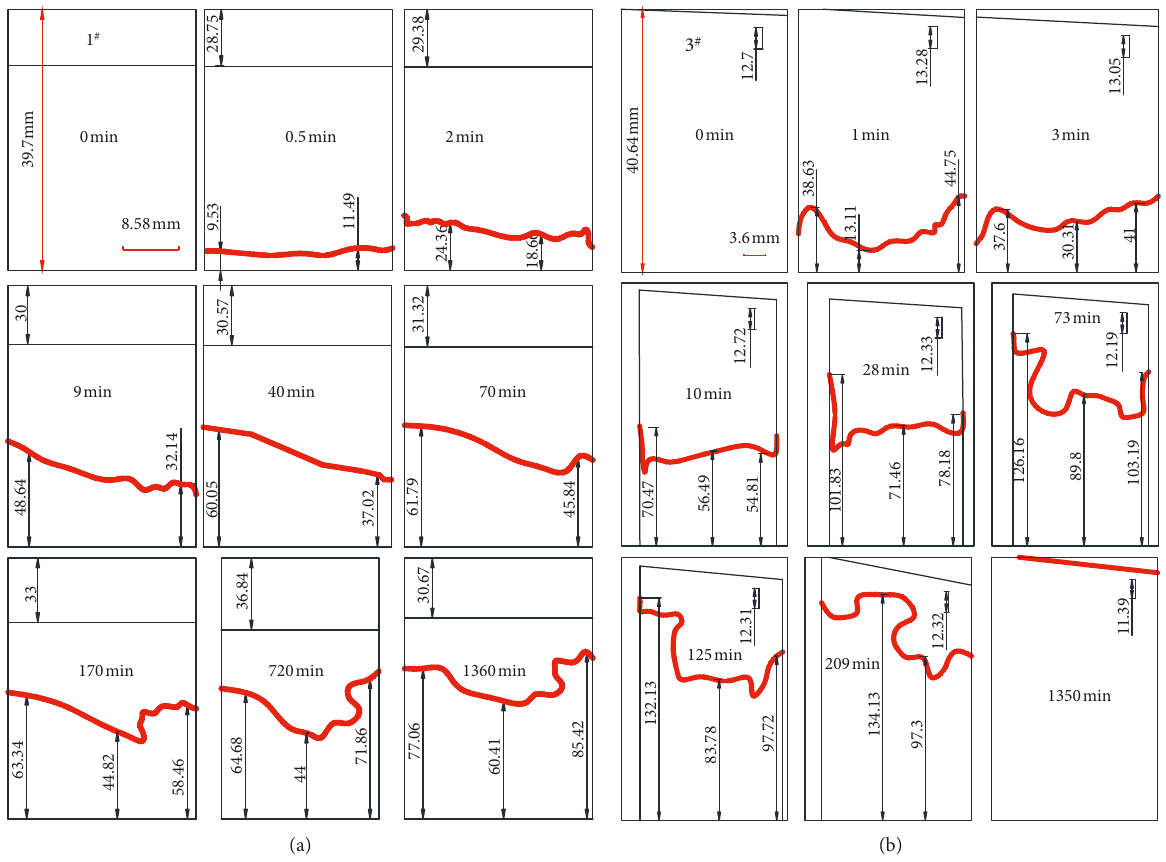
Figure 10: Variation of intruded line over time. (a) 1# sample is under lateral restraints. (b) 3# sample is under free